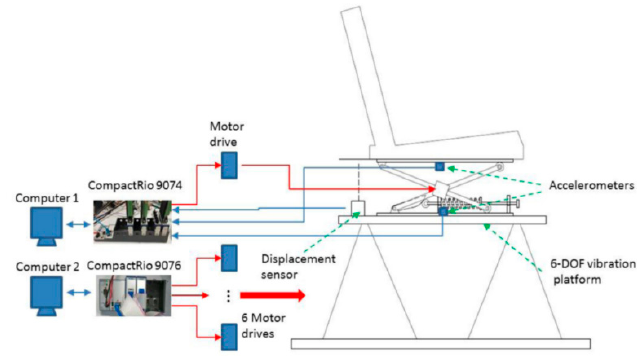
Figure 13. The experimental setup of the system with the terminal sliding mode controller [59].